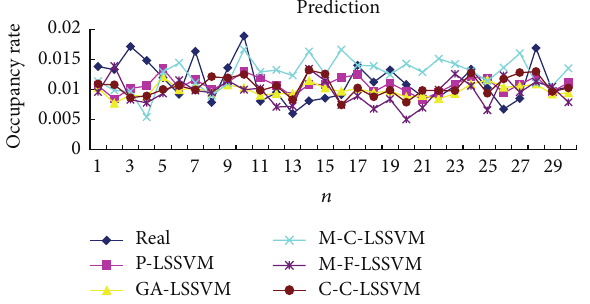
Figure 13: Five models predicted diagram for interphone band.